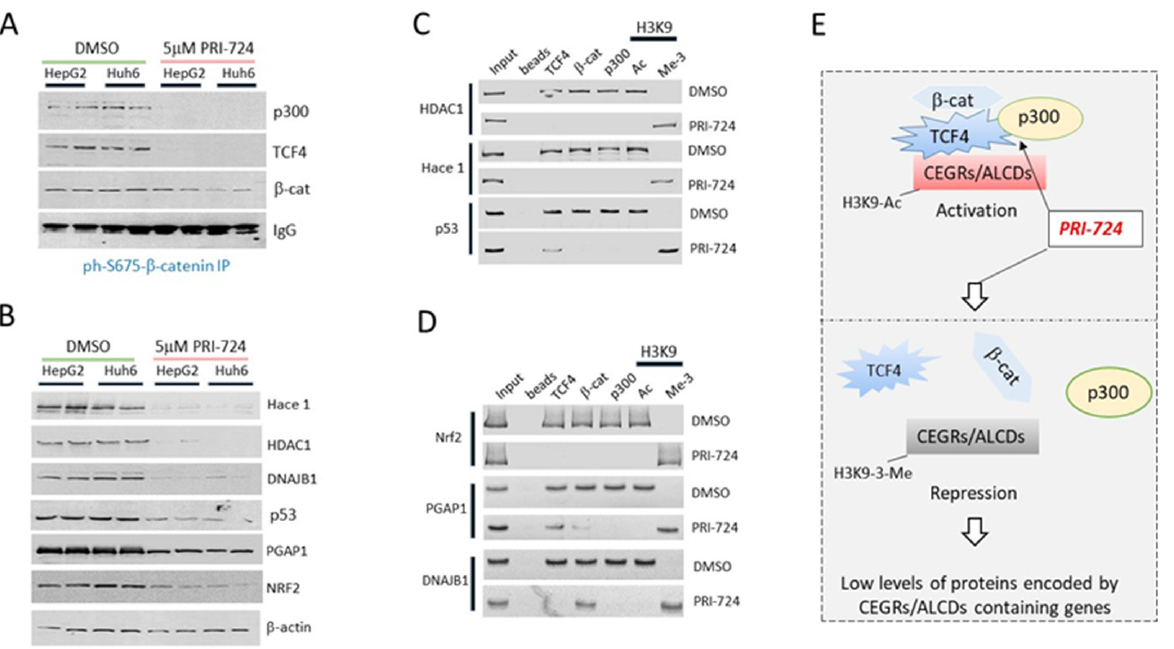
Figure 4. Inhibition of β -catenin in HBL cells removes β -catenin-TCF4-p300 complexes from CEGRs/ALCDs and reduces expression of CEGRs/ALCDs-containing oncogenes. ( A ) Co-IP shows that PRI-724 destroys β -catenin-TCF4-p300 complexes in HepG2 and Huh6 cells. ( B ) Expression of proteins (shown on the right) determined by Western blotting in DMSO and PRI-724-treated HepG2 and Huh6 cells. ( C , D ) ChIP assay with CEGRs/ALCDs of six oncogenes shown on the left. ( E ) A summary of the results of the ChIP assay. The uncropped Western blots have been shown in Figure S9.